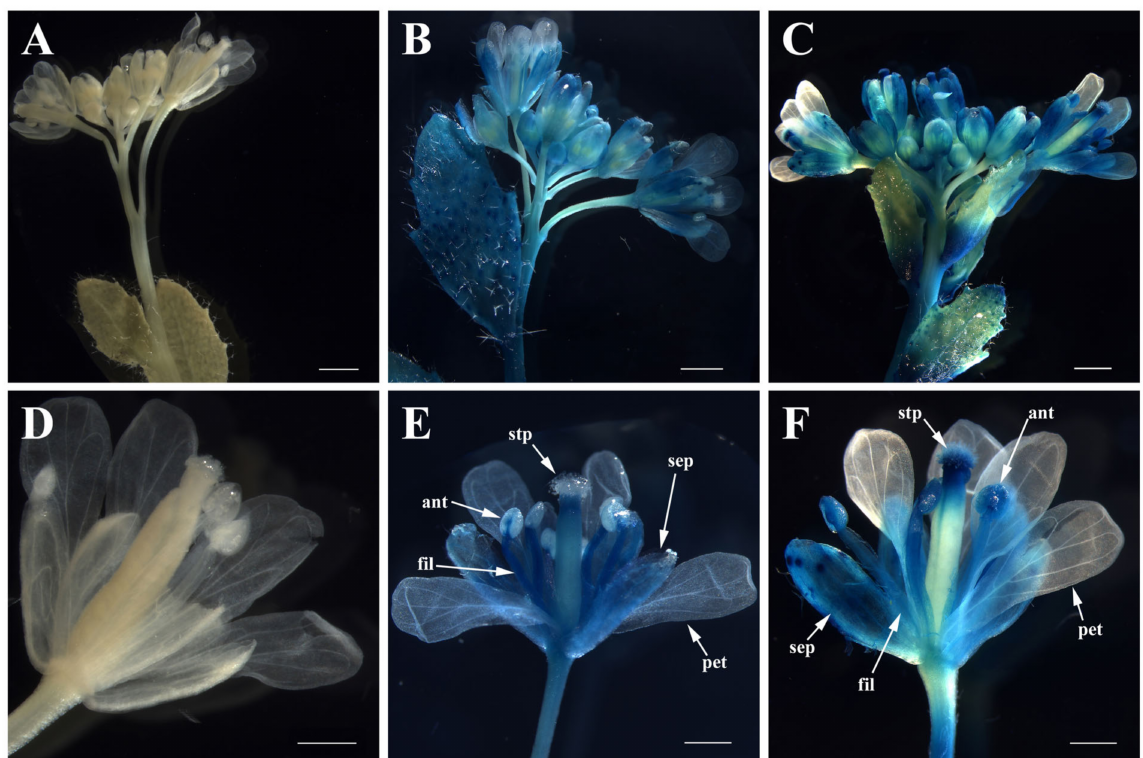
Figure 7. Histochemical GUS staining of pFaesAP3_1::GUS and pFaesAP3_2::GUS transgenic Arabidopsis , respectively. ( A ) Wild-type Arabidopsis inflorescence; ( B ) inflorescence of pFaesAP3_1::GUS transgenic Arabidopsis; ( C ) inflorescence of pFaesAP3_2::GUS transgenic Arabidopsis ; ( D ) wild-type Arabidopsis flower; ( E ) flower of pFaesAP3_1::GUS transgenic Arabidopsis ; ( F ) flower of pFaesAP3_2::GUS transgenic Arabidopsis . Sepal (sep), petal (pet), anther (ant), filament (fil), stigmatic papillae (stp); scale bars: ( A – C ) 1 mm; ( D – F ) 500 µ